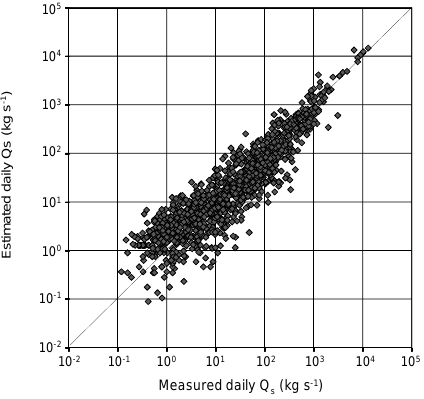
Figure 5. Comparison between estimates of Q s obtained from Q and the global rating curve, and measured Q s